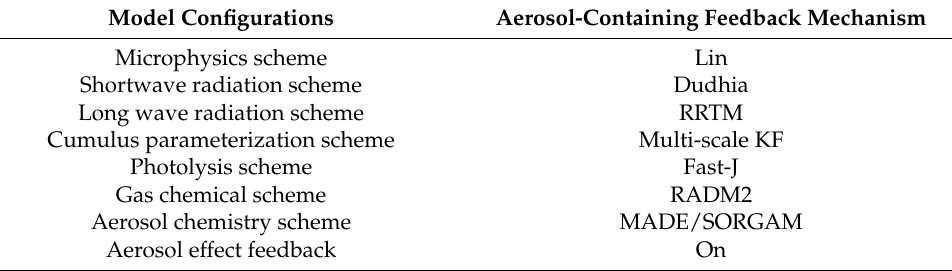
Table 1. Physical and chemical scheme adopted in the WRF-Chem